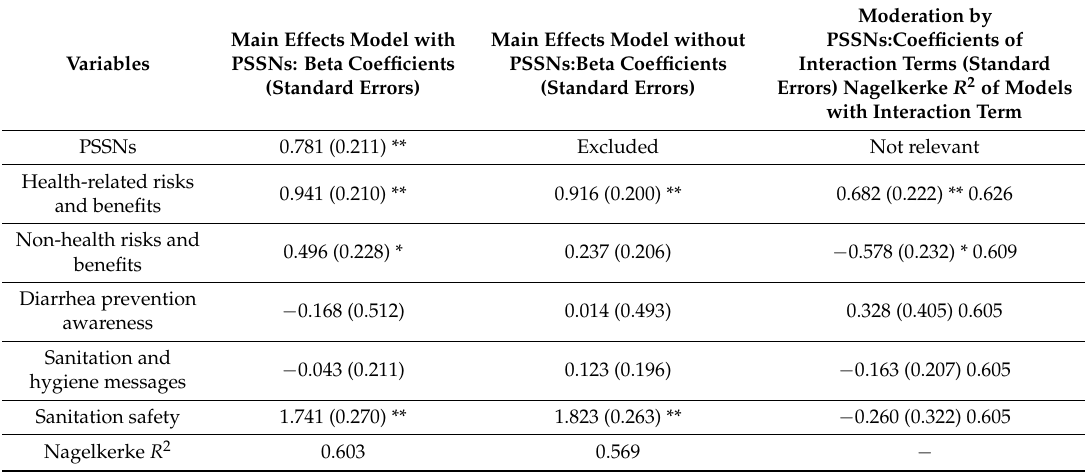
Table 4. Predictors of satisfaction with current sanitation practice (logistic regressions).